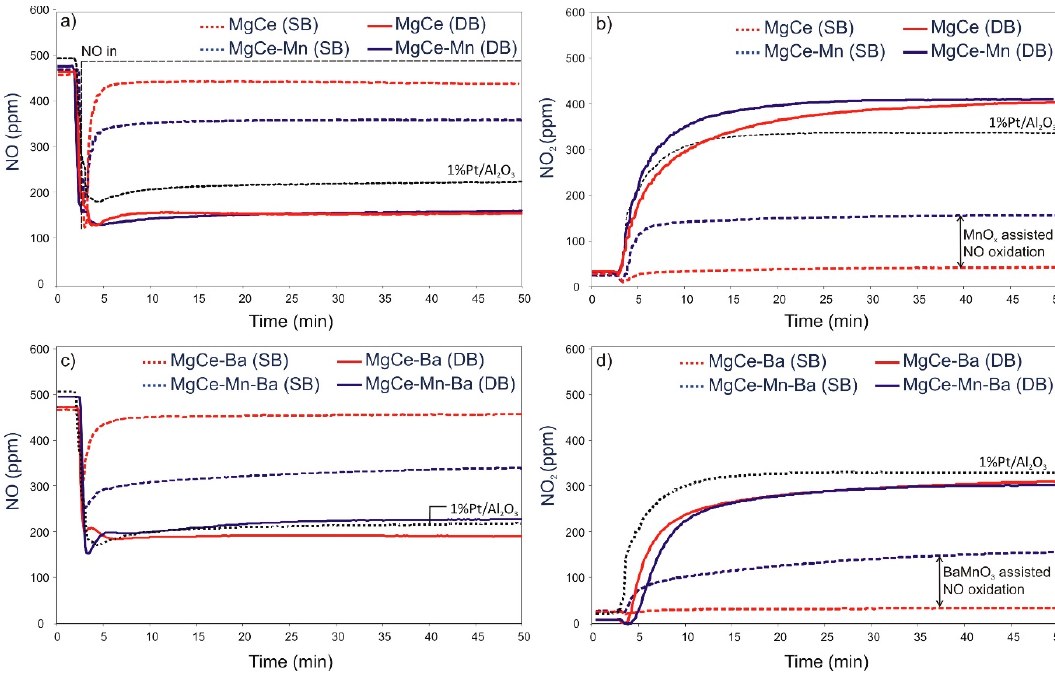
Figure 2. Profiles of NO and NO 2 of during NO x adsorption at 300 ◦ C under single-bed (SB) and dual-bed (DB) conditions. ( a ) NO and ( b ) NO 2 profiles of MgCe and MgCe-Mn. ( c ) NO and ( d ) NO 2 profiles of MgCe-Ba and MgCe-Mn-Ba. Profiles of Pt / alumina are included for comparison.